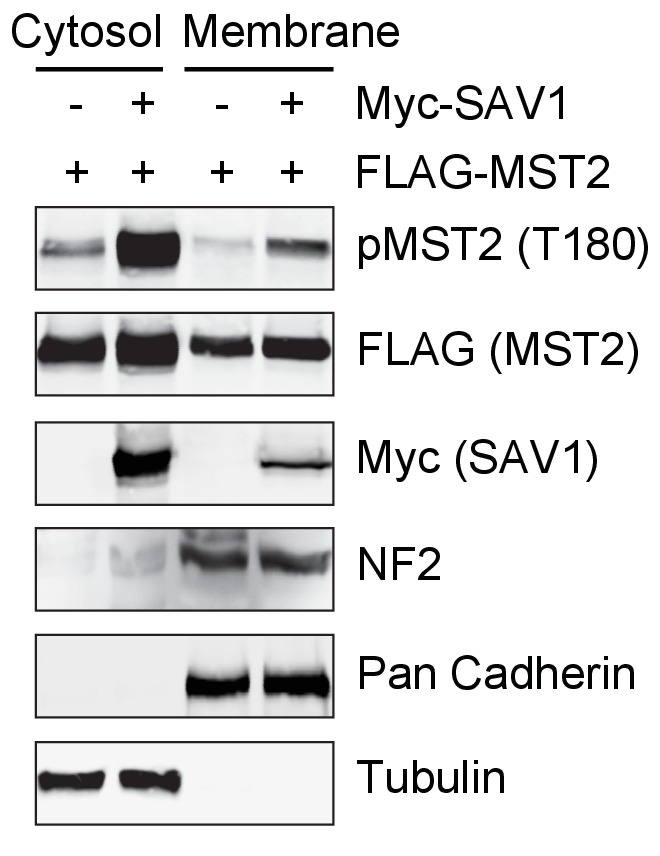
SAV1 and MST2 are present in the cytosol.FLAG-MST2 and Myc-SAV1 were co-transfected into 293FT cells. Cells were collected after 24 hr and subjected to cytosol-membrane fractionation using the membrane protein extraction kit (Thermo Scientific). The cytosol and membrane fractions were blotted with the indicated antibodies. Tubulin, NF2 and Pan Cadherin were used as markers for cytosolic, peripheral membrane, and integral membrane proteins, respectively.